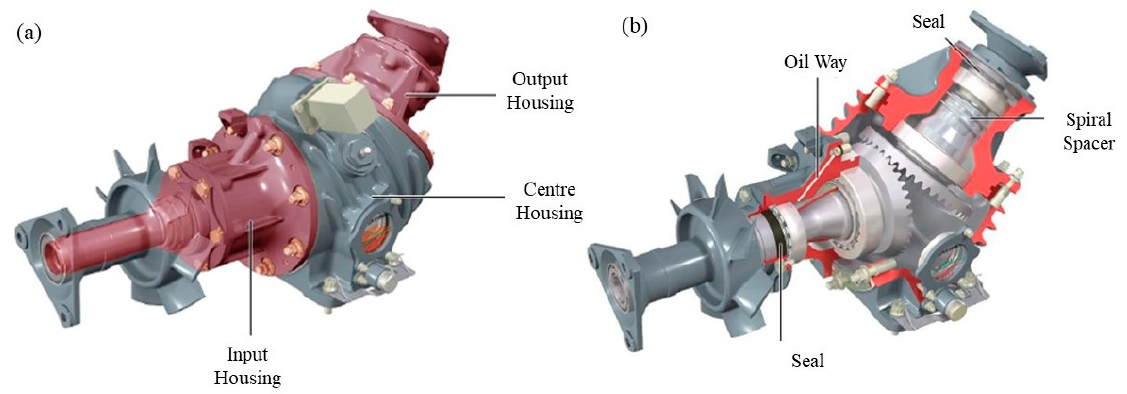
Table 2. Motor Specifications. Figure 3. ( a ) Intermediate gearbox (IGB) schematic showing input and output housing ( b ) IGB schematic showing placement of seals in the input and output housing.